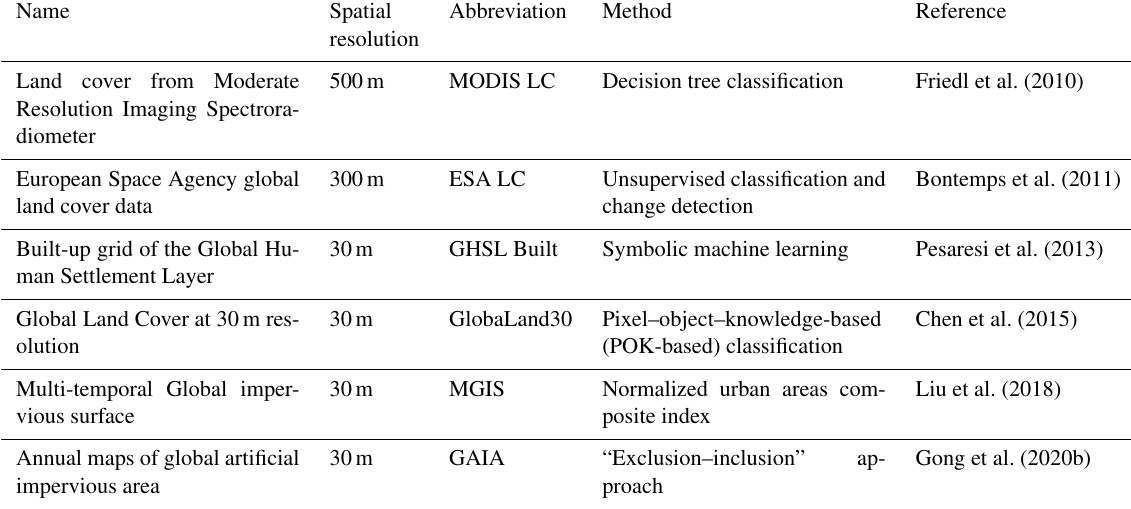
Table 4. A summary of existing urban land